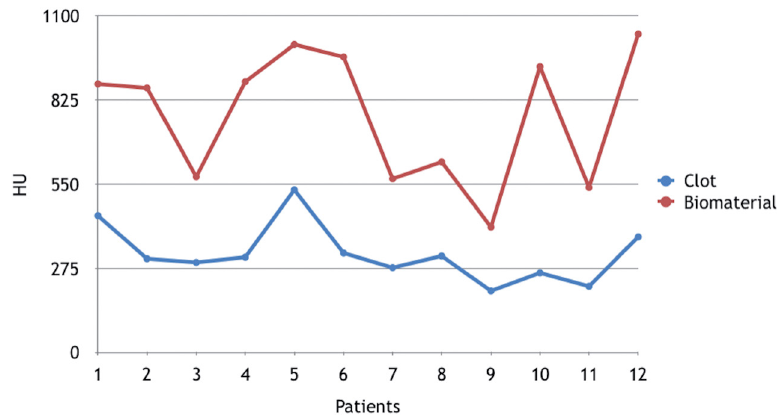
Figure 5- Measurement, in HU, of the bone density of clot-filled socket and biomaterial in each